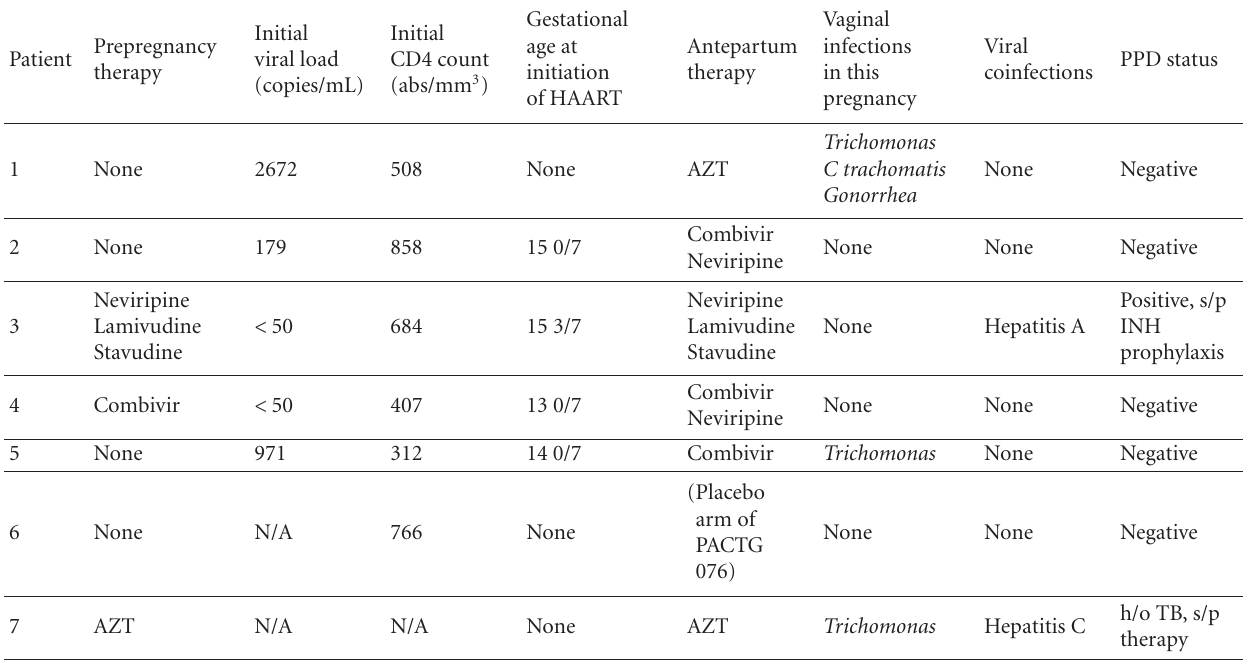
Table 2: HIV and infectious morbidity. HIV: human immunodeficiency virus; AIDS: acquired immunodeficiency syndrome; HAART: highly active antiretroviral therapy; AZT: zidovudine; INH: isoniazide; PACTG: the Pediatric AIDS Clinical Trials Group; TB: tuberculosis; S/P: